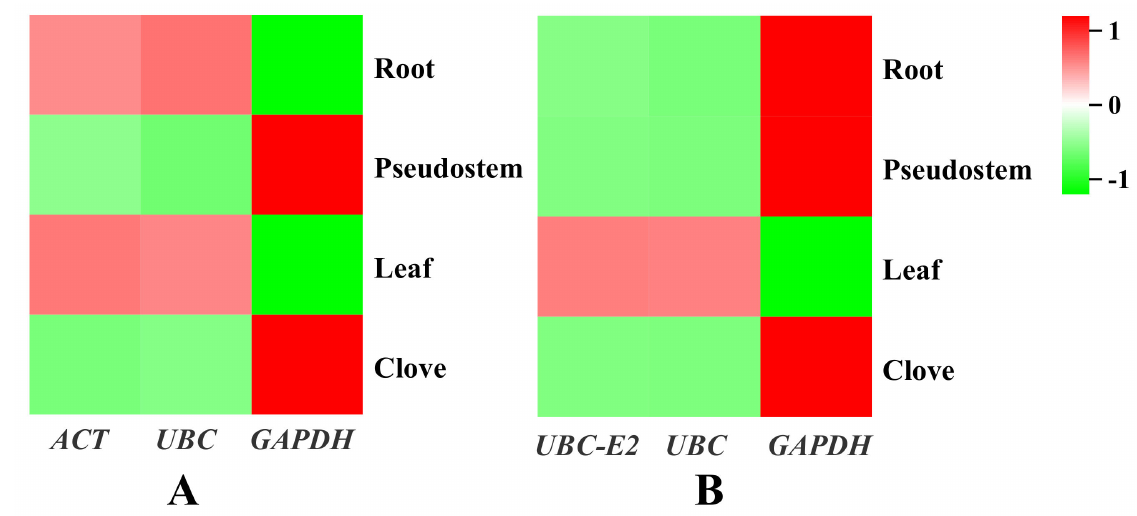
Figure 6. AsAPX expression in different parts of garlic under drought( A ) and cold( B